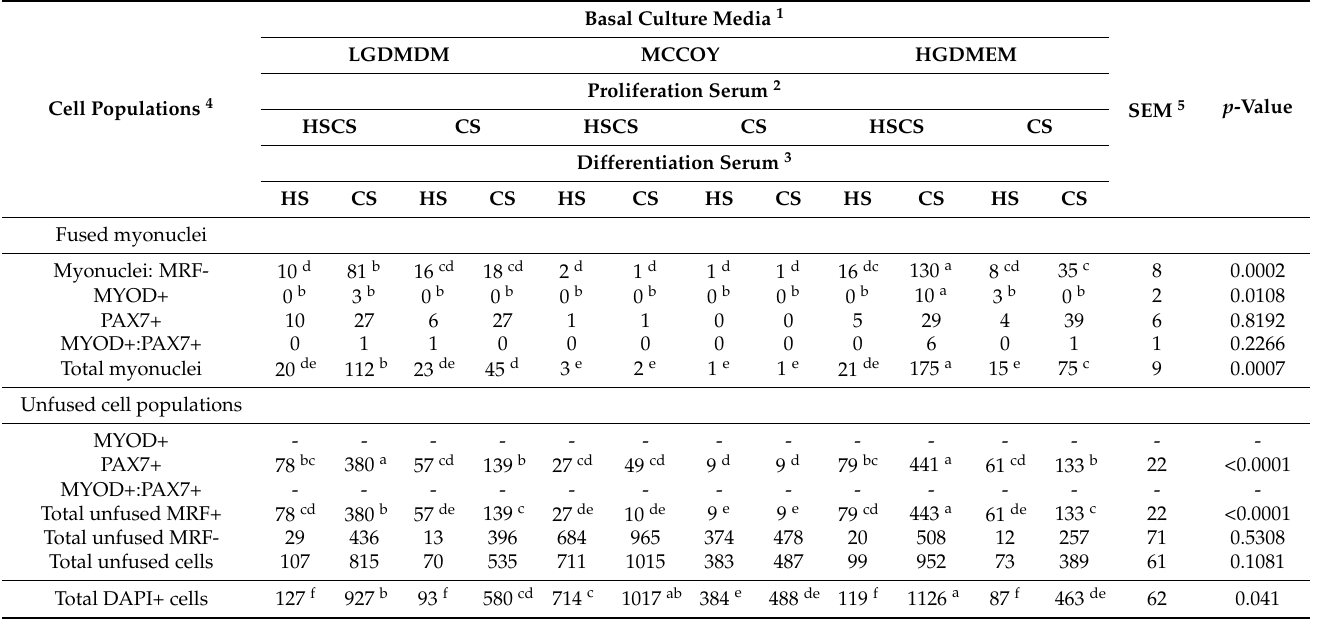
Table 4. The effect of basal culture media, proliferation serum, and differentiation serum on differen- tiating satellite cell heterogeneity at 96 h